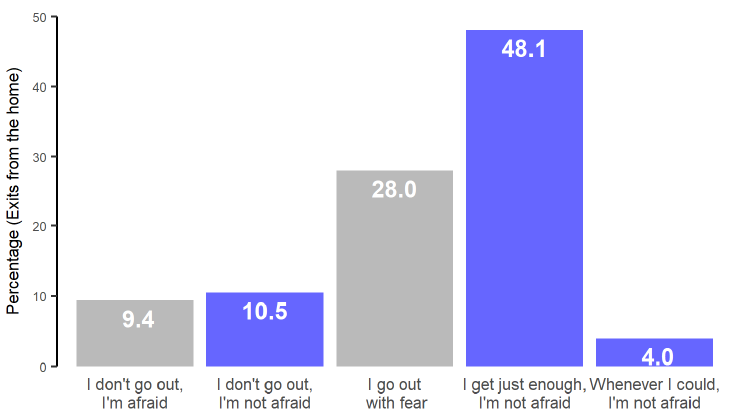
Figure 6. Fear and leaving the house. Lockdown Survey [59]. The options to choose when answering the question were the following: (i) I have not gone out during the entire period of confinement and I am afraid to do so; (ii) I have not gone out during the entire period of confinement, but I am not afraid; (iii) I go out to do errands (walking the dog, shopping, work, care . . . ) and I do so with